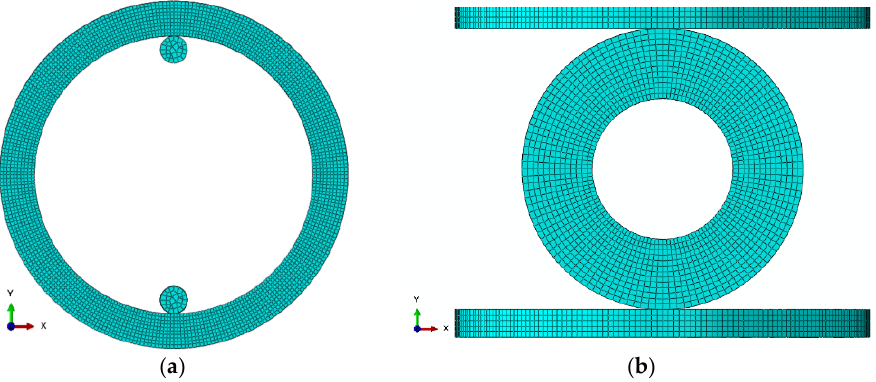
Figure 8. FEA model: ( a ) O-ring tension and ( b ) O-ring compression test. O-ring FEA simulations were repeated 100 times using 100 randomly generated data sets. With this method, we also included the virtual friction parameter of rubbers, which is only possible experimentally by performing additional testing. The randomly created hyperelastic material parameters and friction coefficients for 100 cases are shown in Table 1. Table 1. Randomly generated material parameters.